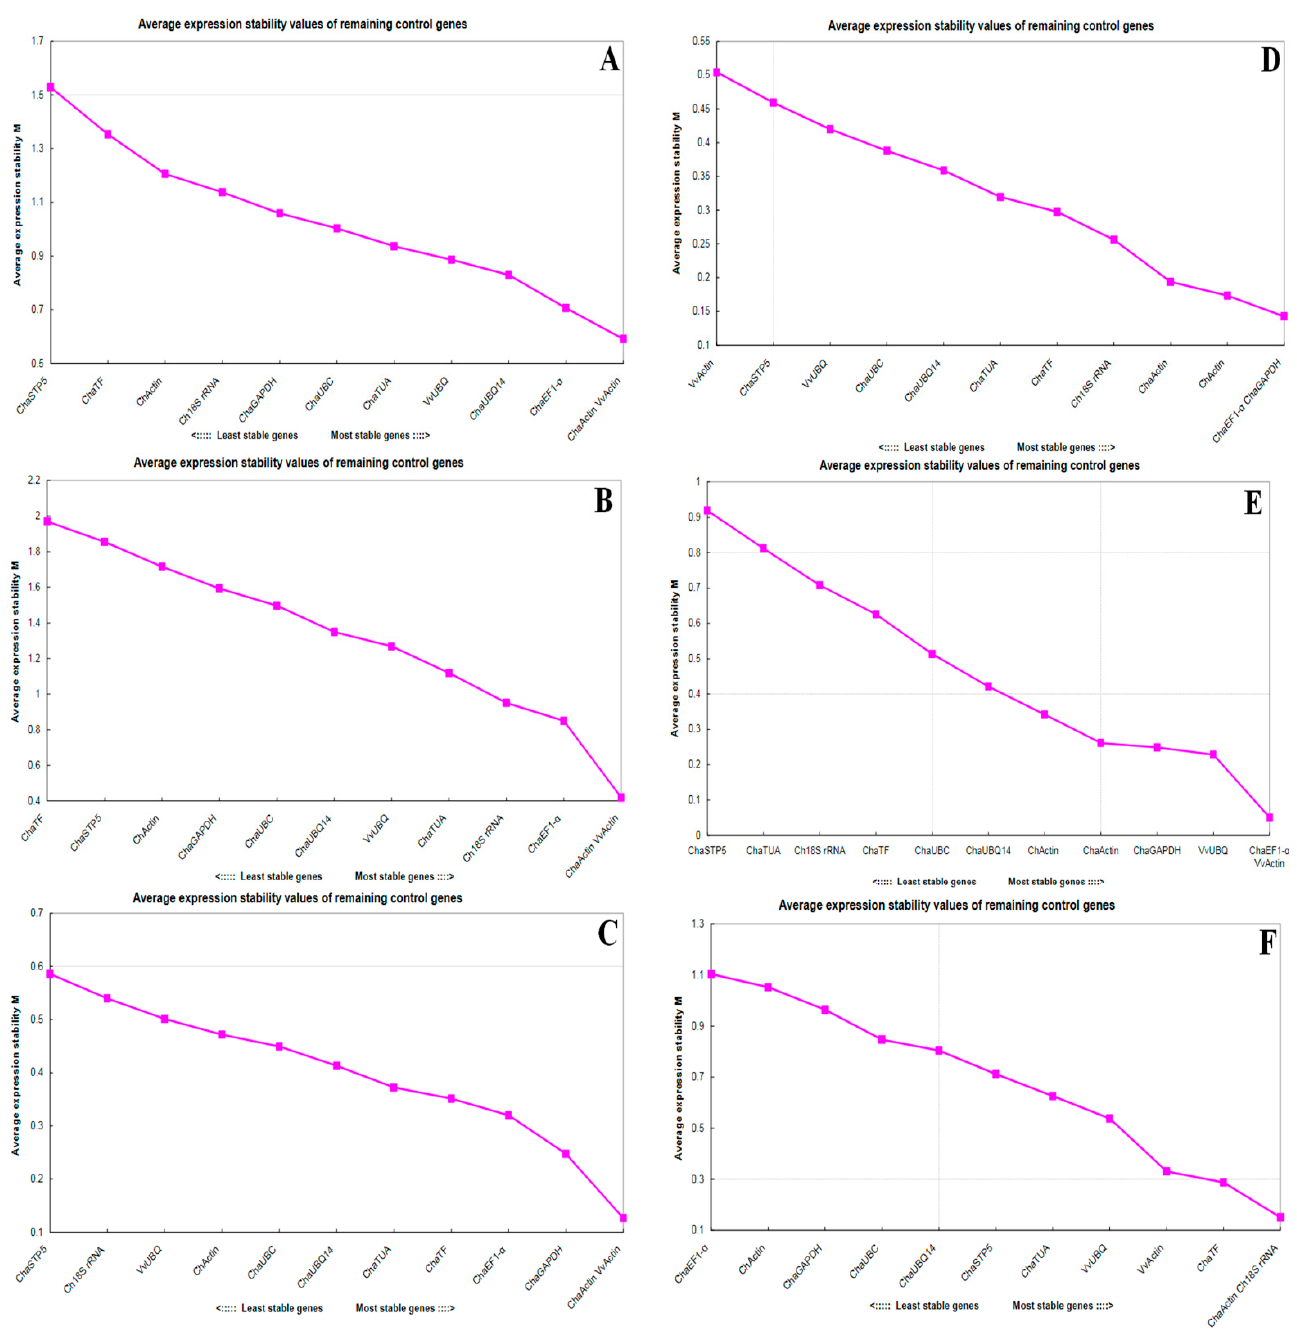
Figure 4. Expression stability (M) of twelve reference genes across different sample groups calculated using geNorm. M values of reference genes ( A ) in 24 sample groups, ( B ) in different tissues, ( C ) at different times after pollination, ( D ) in styles at 4 h after cross/self-pollination, ( E ) at different stages of flowering, and ( F ) in male catkins at different stages of elongation. The optimal number of reference genes could also be determined using geNorm, according to the pairwise variation value (Vn/n + 1). The default cut-off threshold of 0.15 was applied, where a Vn/Vn + 1 value < 0.15 indicates that n reference genes would be needed for accurate normalization, without introducing another (n + 1) reference gene. was 0.145 (<0.15), suggesting that five reference genes ( ChaActin , VvActin , ChaEF1- α ,